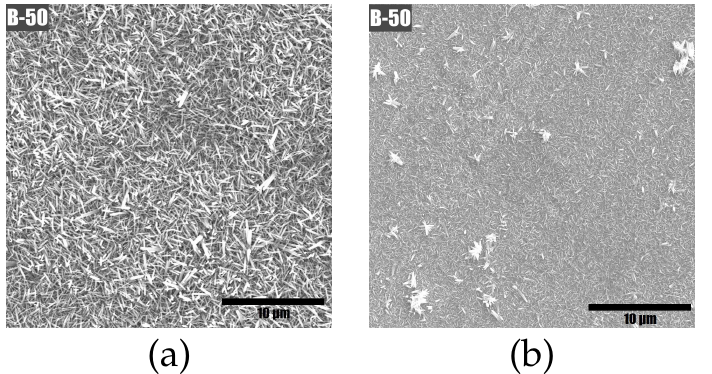
Figure 5. Scanning electron top-view micrographs of sample B-50 showing the ZnO nanowires on samples coming from a process carried out in a container vessel placed on a hotplate ( a ) and on a heated magnetic stirrer ( b ).